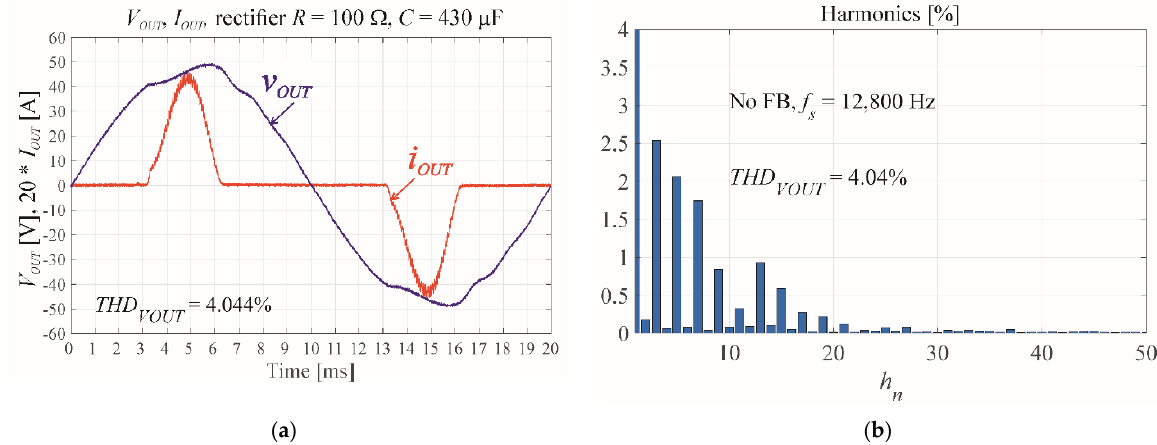
Figure 10. ( a ) The output voltage and current; ( b ) The harmonics analysis of the output voltage without the feedback loop for f s = 12,800 Hz (RC load: R = 100 Ω , C = 430 μ F).